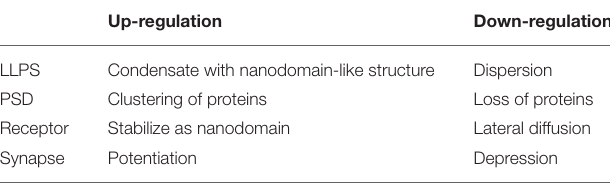
TABLE 1 | Corresponding relationship from LLPS to the